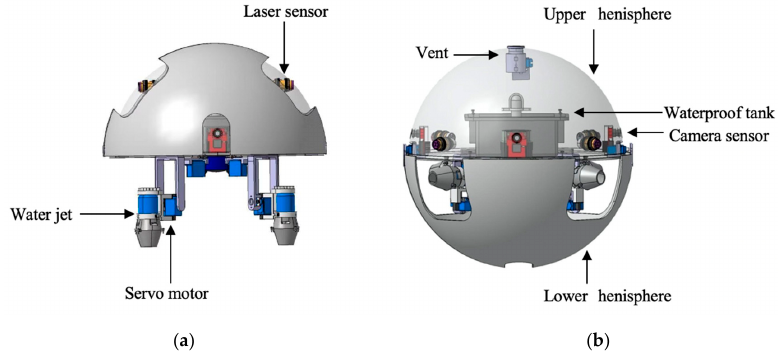
Figure 2. Two modes of the spherical amphibious robot. ( a ) underwater mode; ( b ) land